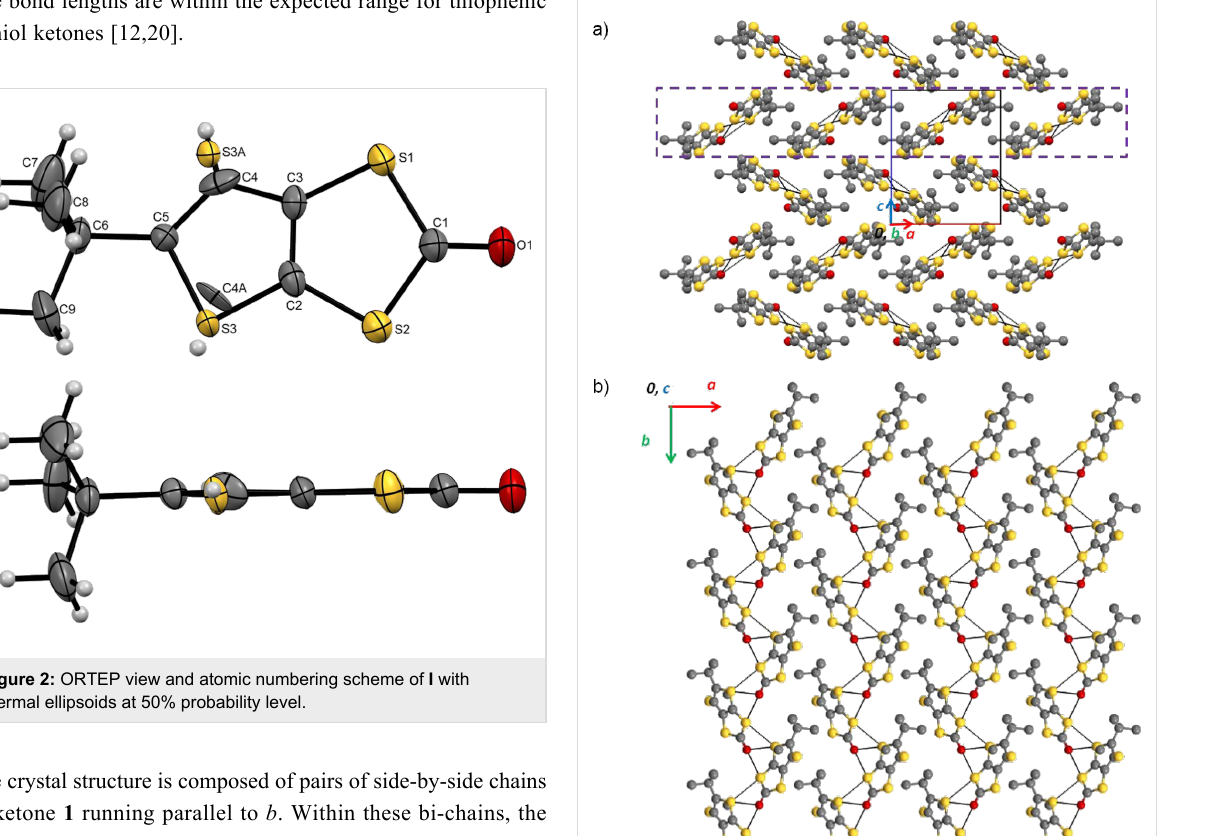
The bond lengths are within the expected range for thiophenic dithiol ketones [12,20].